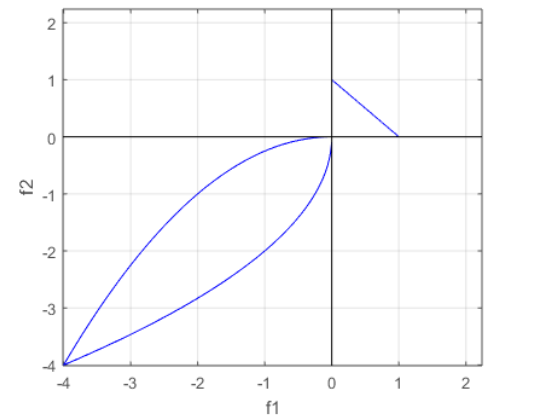
Figure 1. Topological boundary of the initial Cournot payoff space im ( c ) . That is, boundary of the payoff space of game G µ ( 0 ) .